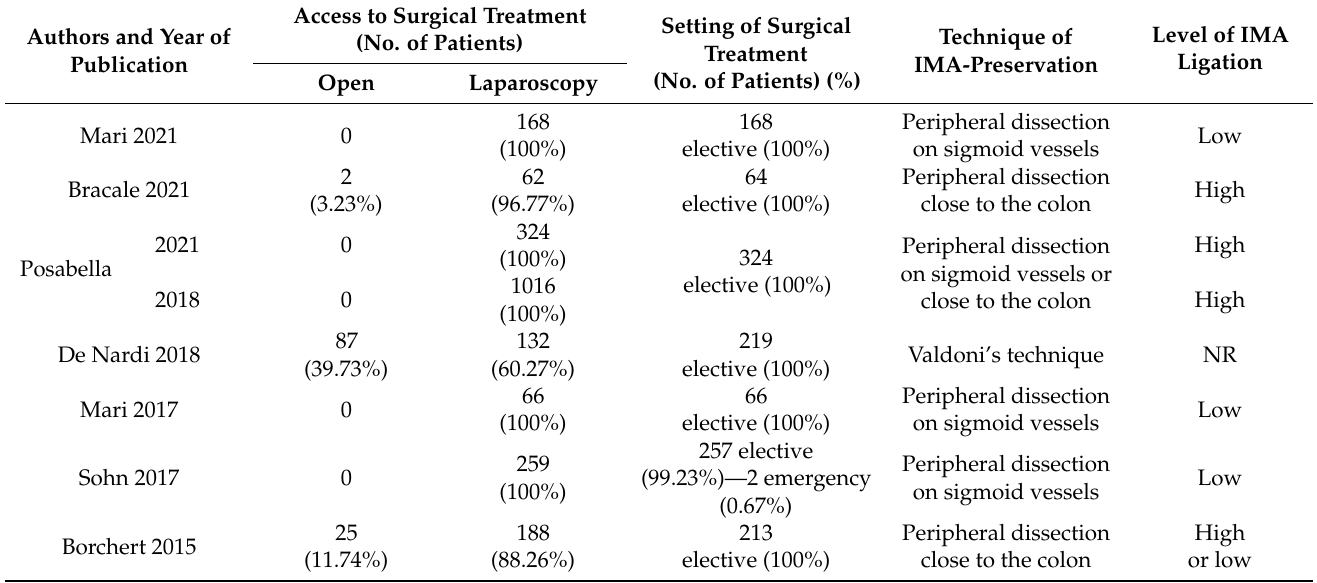
Table 2. Characteristics of surgical treatment in included